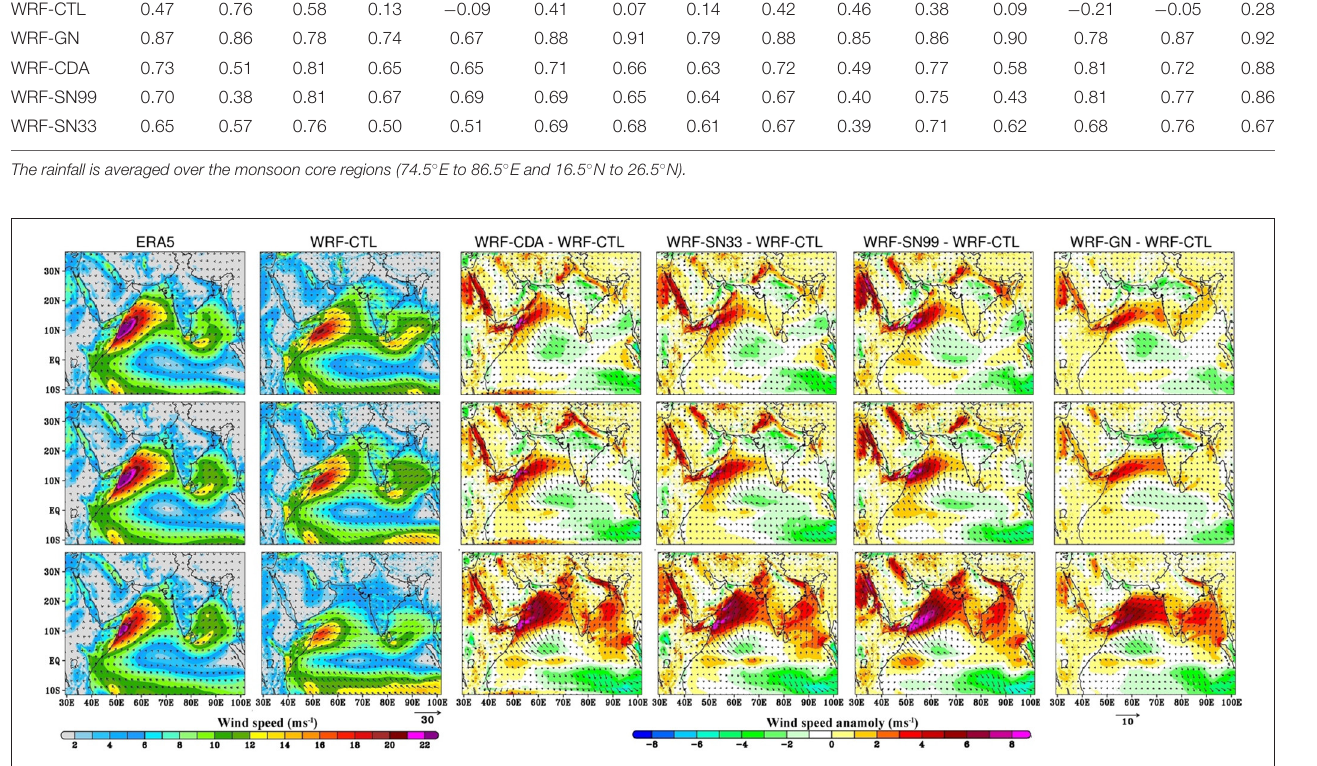
over central India, the monsoon core region, compared to all other